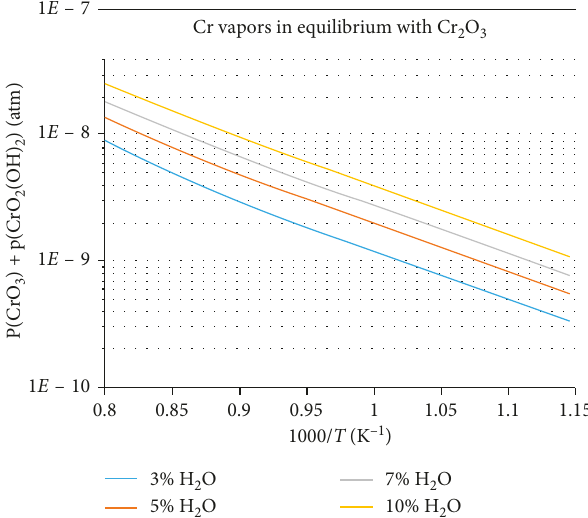
Figure 6: Partial pressures of chromium vapor species varying with temperature for different partial pressures of H 2 O. Wherein, 0.209 atm (partial pressure of oxygen in P(O 2 ) (cid:31)